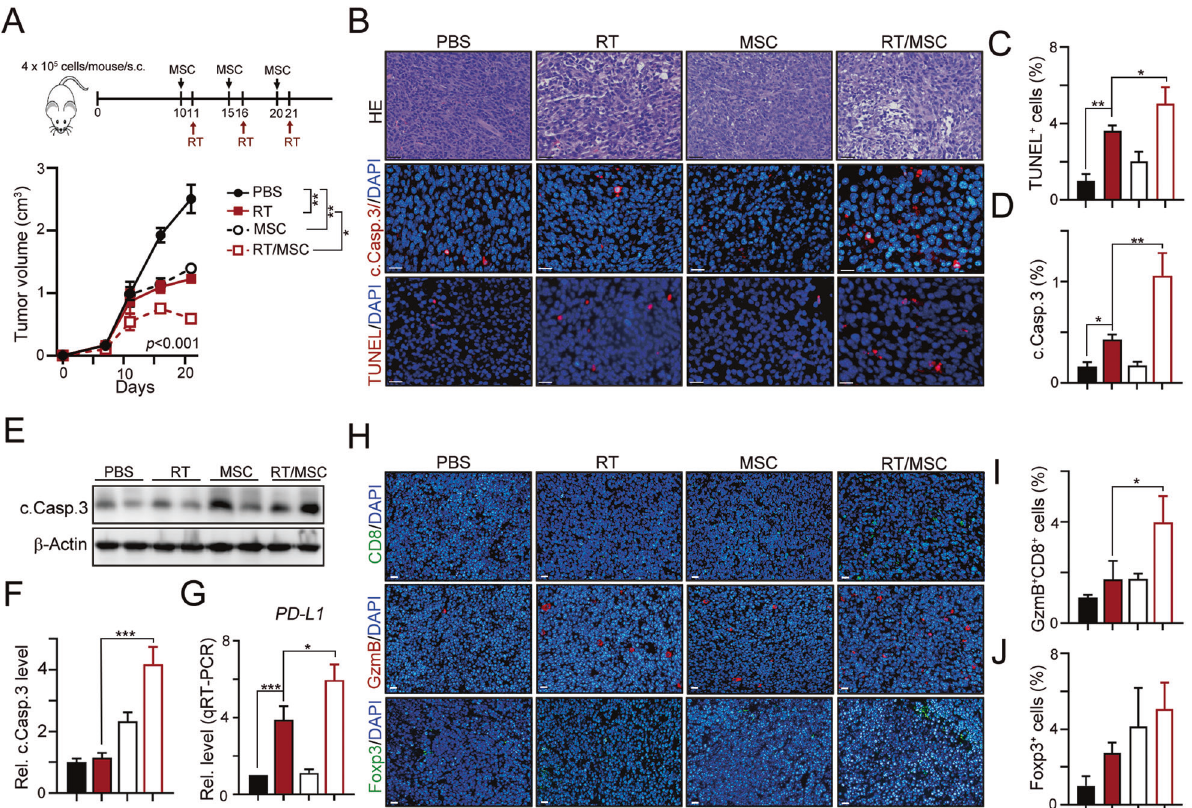
Fig. 4 MSC enhanced the therapeuti ef fi cacy of RT by remodulating tumor microenvironment in vivo. A About 4 × 10 5 CT26 shSTING cells were subcutaneously inoculated into the left leg of BALB/c mice for 10 days ( n = 5). About 1 × 10 6 MSC were intraperitoneally injected into tumor-bearing BALB/c mice on days 10, 15, and 21. Local radiotherapy (5 Gy) was given on days 11, 16, and 21. Tumor volume was measured every 3 days. * p < 0.05 and ** p < 0.01. B Tumors were harvested on day 26 for immunohistochemistry. The representative result of cleaved caspase-3 and apoptotic cells was shown. Scale bar: 20 μ m. C The TUNEL + apoptotic cells were evaluated (mean ± SEM, n = 3). * p < 0.05 and ** p < 0.01. D The cleaved caspase-3 cells were evaluated (mean ± SEM, n = 3). ** p < 0.01 and *** p < 0.001. E The level of cleaved caspase-3 was analyzed. F The quanti fi cation of cleaved caspase-3 cells was shown (mean ± SEM, n = 3). *** p < 0.001. G The level of PD-L1 (CD274) was evaluated by qRT-PCR (mean ± SEM, n = 3). *** p < 0.001. H The tumor-in fi ltrating cytotoxic CD8 + , Granzyme B + , and Foxp3 + Treg cells was evaluated by immuno fl uorescent analysis. Scale bar: 20 μ m. I The quanti fi cation of cytotoxic CD8 + GzmB + cells was shown (mean ± SEM, n = 3). * p < 0.05. J The quanti fi cation of cytotoxic Foxp3 + Treg was shown (mean ± SEM, n =